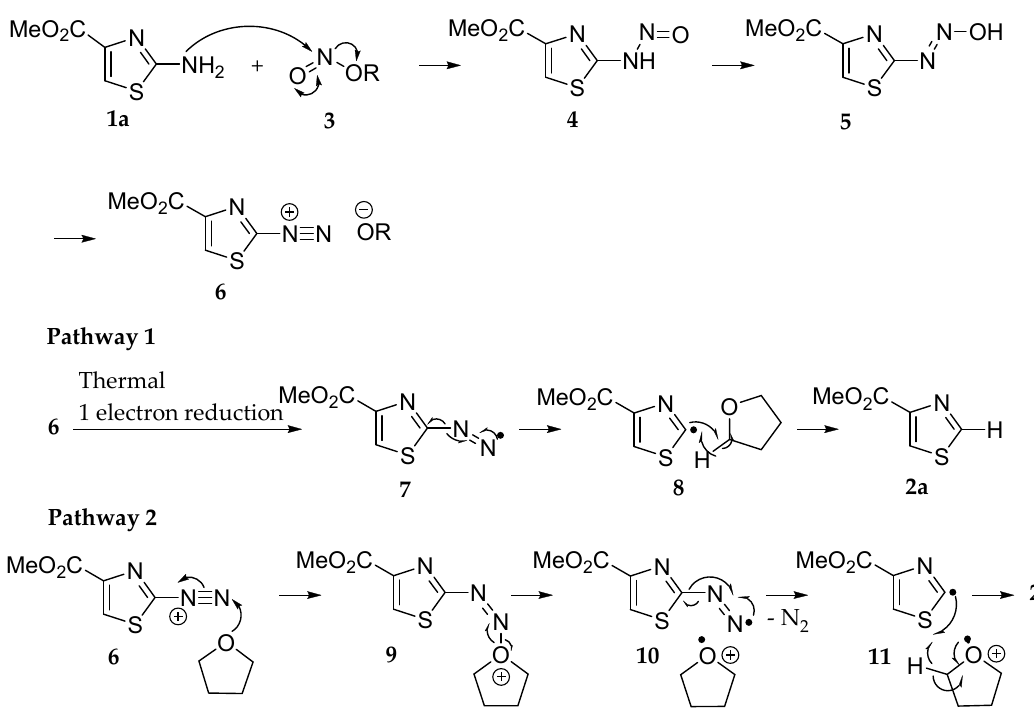
Figure 2. The postulated mechanism for the formation of the aryl radical and termination to the target hydrogenated product.